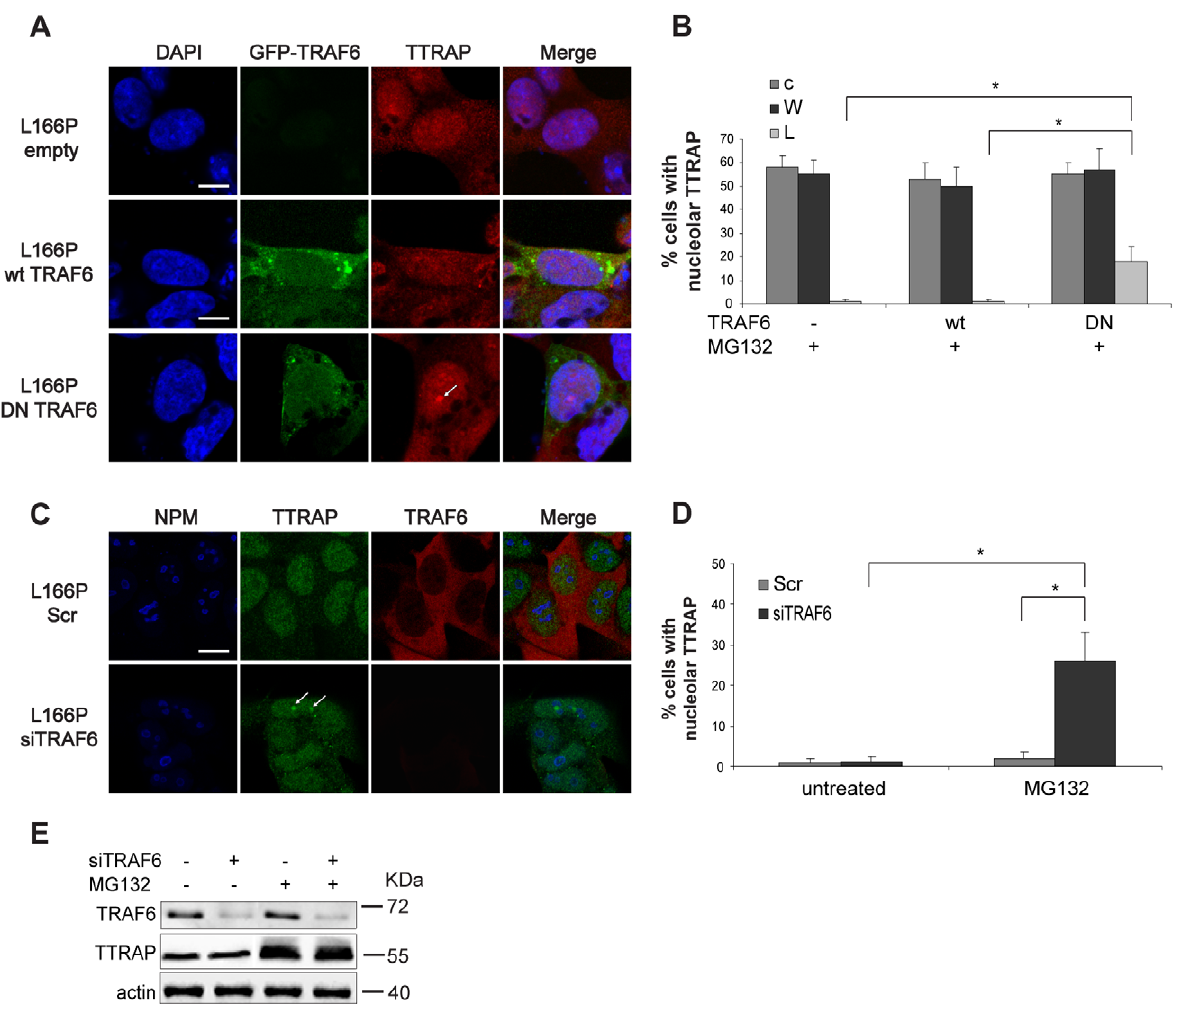
Figure 6. TRAF6 E3 ligase activity contributes to L166P-mediated exclusion of TTRAP from nucleolar cavities. (A) Expression of TRAF6 DN partially rescues TTRAP nucleolar localization in L166P cells. SH-SY5Y cells stably expressing mutant DJ-1 were transfected with GFP-tagged TRAF6 (wt or deleted of the N-terminus, DN), or with empty vector control, as indicated. After 24 h from transfection, cells were treated for 16 h with MG132. TTRAP localization was followed by indirect immunofluorescence coupled with GFP autofluorescence. Bars, 10 m m. (B) Quantification of TTRAP nucleolar localization. Cells were as in A. At least 100 transfected cells with comparable GFP levels from two independent experiments were counted and scored for TTRAP in the nucleolus (*, p , 0.05). (C) Knock-down endogenous TRAF6 expression partially rescues TTRAP nucleolar localization. SH- SY5Y cells stably transfected with mutant DJ-1 L166Pwere transfected with siRNA oligonucleotides targeting endogenous TRAF6 (siTRAF6) or with a scramble control siRNA (Scr). After 72 h from transfection, cells were treated for 16 h with MG132. Immunofluorescence was performed with anti- TTRAP (green), anti-TRAF6 (red), anti-NPM (blue). Bars, 15 m m. (D) Quantification of TTRAP nucleolar localization. Cells were as in C. Analysis was performed as in B on cells with reduced TRAF6 expression (*, p , 0.05). (E) Total cell lysates were prepared from SH-SY5Y cells transfected as in C. Cells were treated with MG132 for 16 h or left untreated. Expression of endogenous TRAF6 and TTRAP was measured with specific antibodies. Protein loading was controlled by beta-actin. Molecular weight markers (MWM) are indicated for each gel (kDa). Images are representative of two independent experiments.